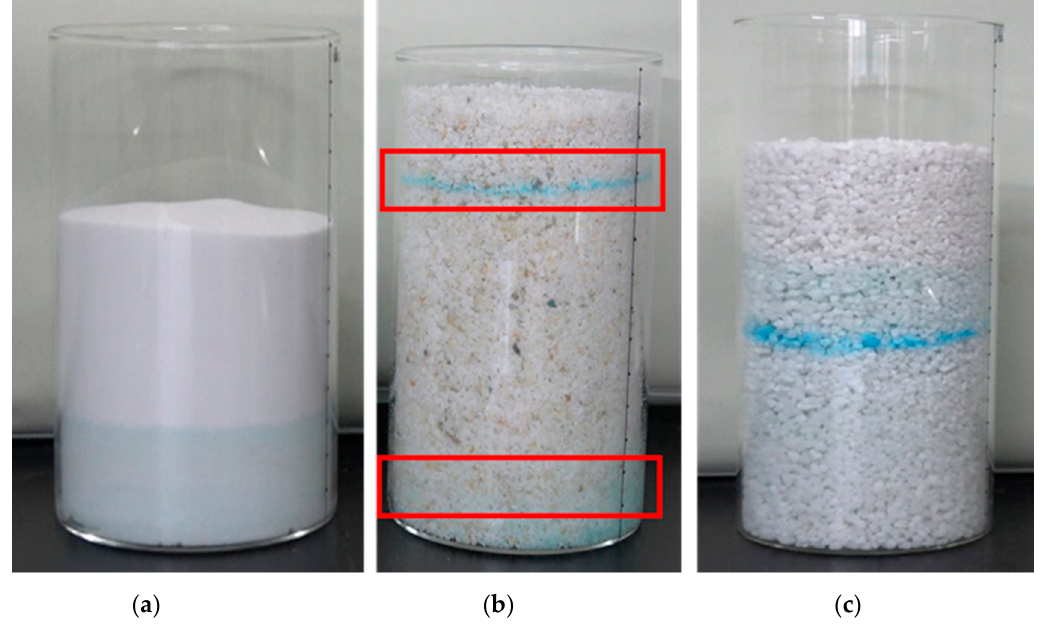
Figure 6. Migration crystallization state of salt solution inside samples. ( a ) B2; ( b ) C2; ( c ) D2.